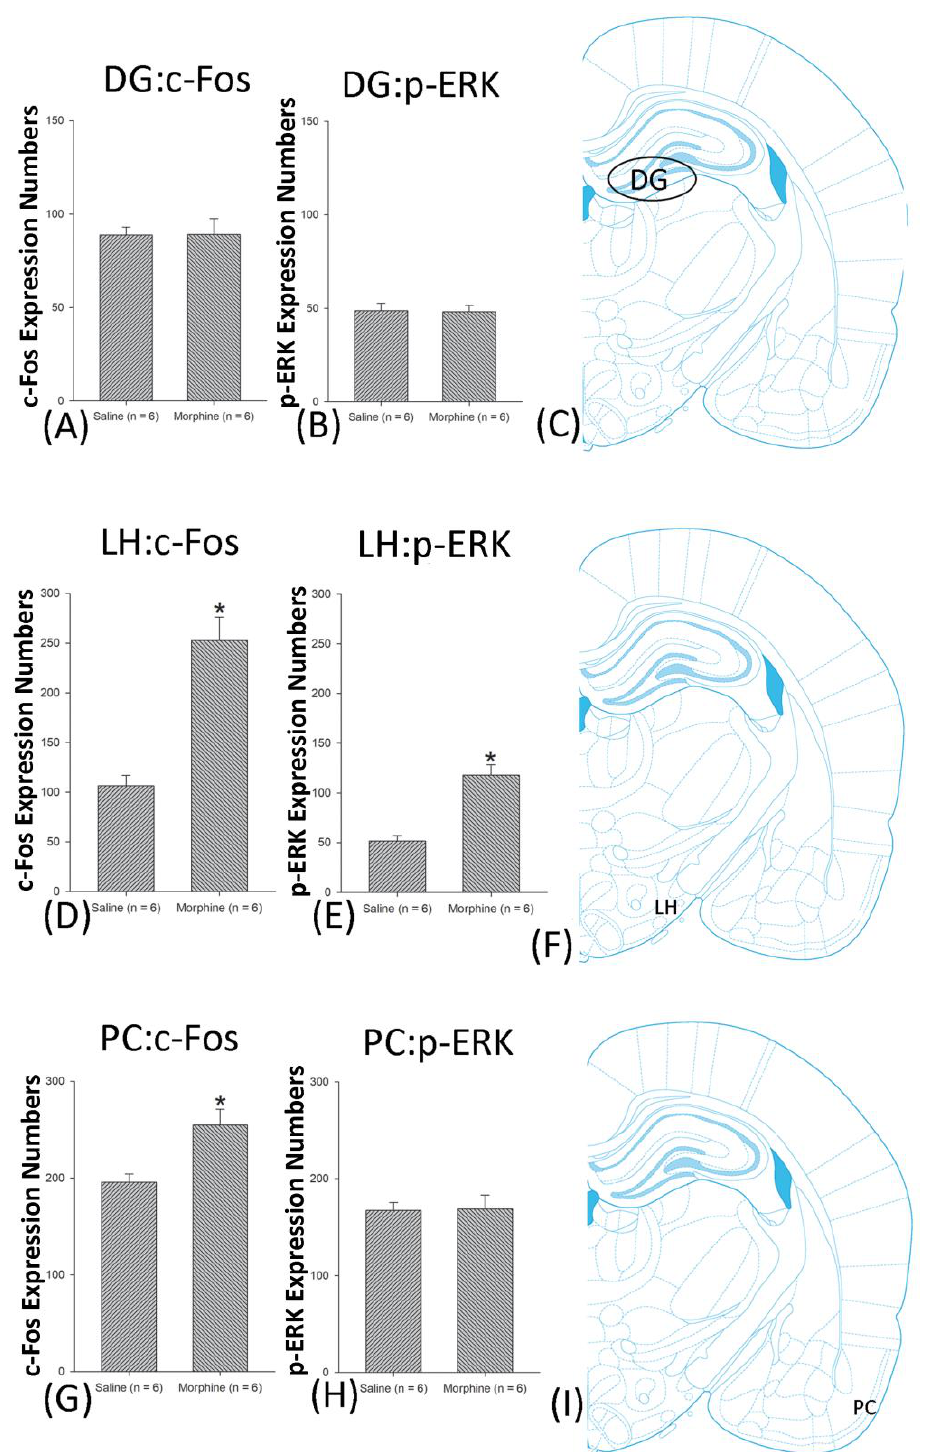
Figure 17. c-Fos or p-ERK expression in the dentate gyrus (DG), lateral hypothalamus (LH), and piriform cortex (PC) in reinstatement. ( A ) c-Fos and ( B ) p-ERK expression in the DG, ( D ) c-Fos and ( E ) p-ERK expression in the LH, and ( G ) c-Fos and ( H ) p-ERK expression in the PC for reinstatement. ( C , F , I ) indicate a schematic representation of the DG, LH, and PC. * p < 0.05 when comparing the saline and morphine groups ( n = 6 per group).